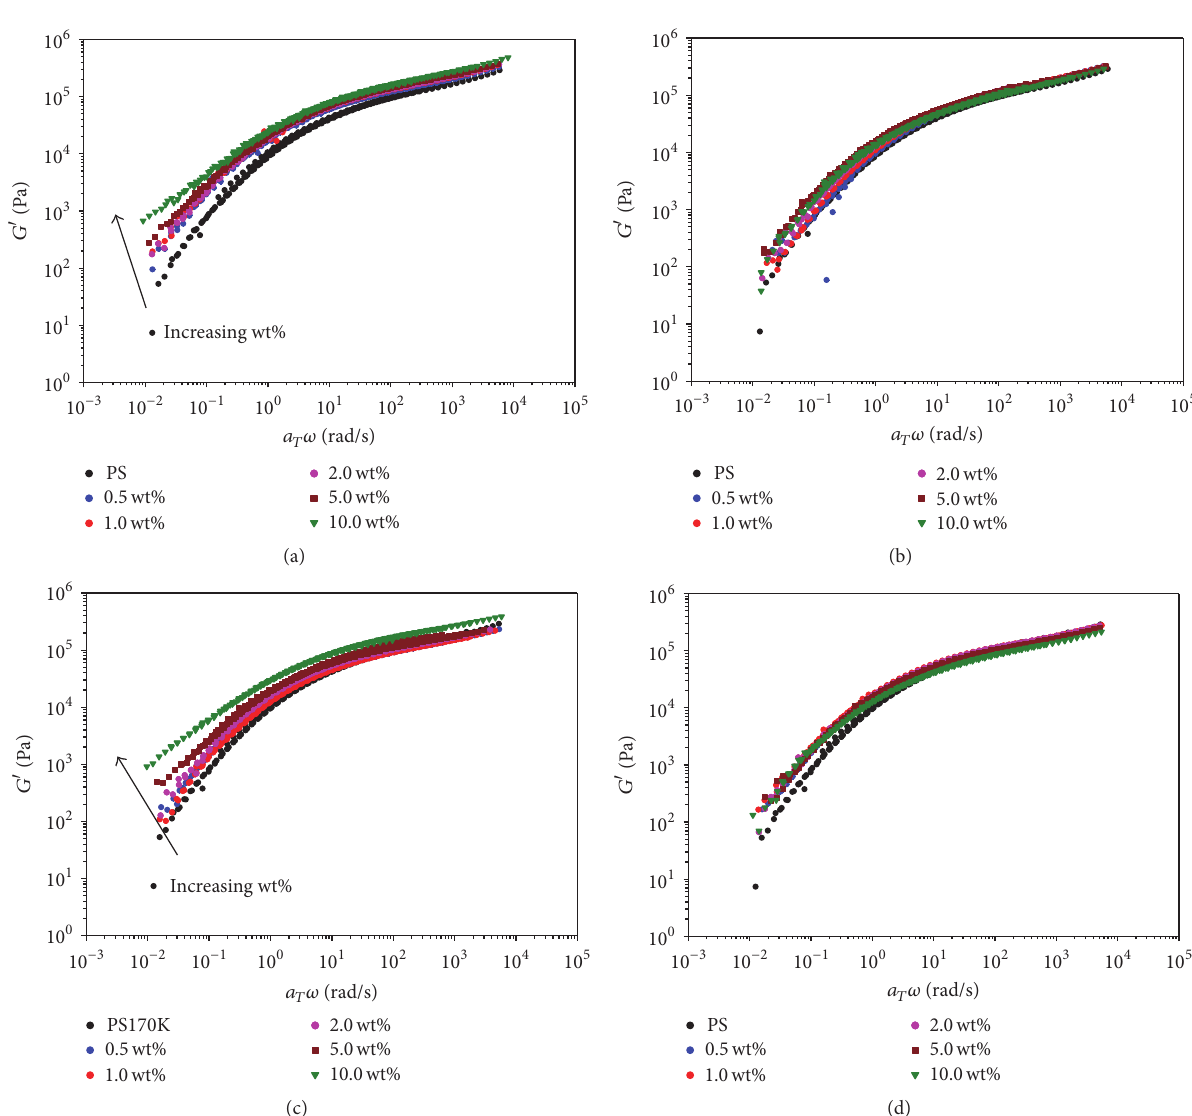
Figure 2: Master curve of storage modulus of (a) PS/nanofiber, (b) PS/SI23, (c) PS/nanosheet, and (d) PS/SI43 blend with varying weight fraction of fillers. The reference temperature is 180 ∘ C.